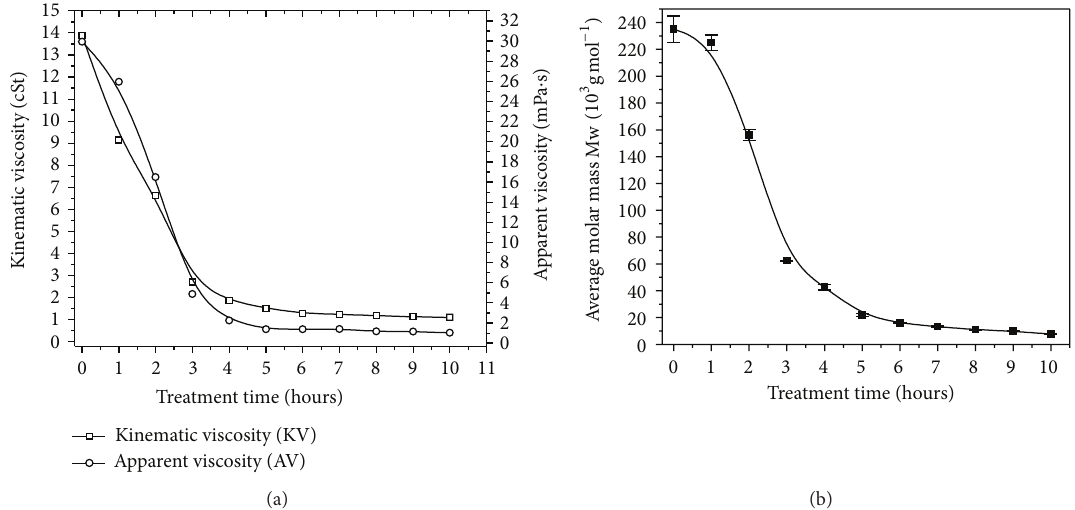
Figure 1: Kinematic and apparent viscosities (a) and average molar mass (b) of chitosans in solid state thermally degraded at 100 ∘ C for up to 10h.